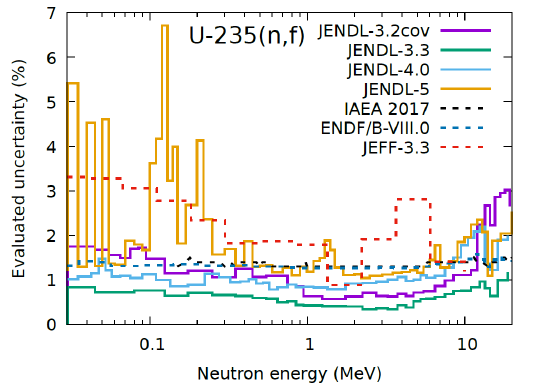
Fig. 2. Uncertainty of 235 U fission cross sections in JENDL and other